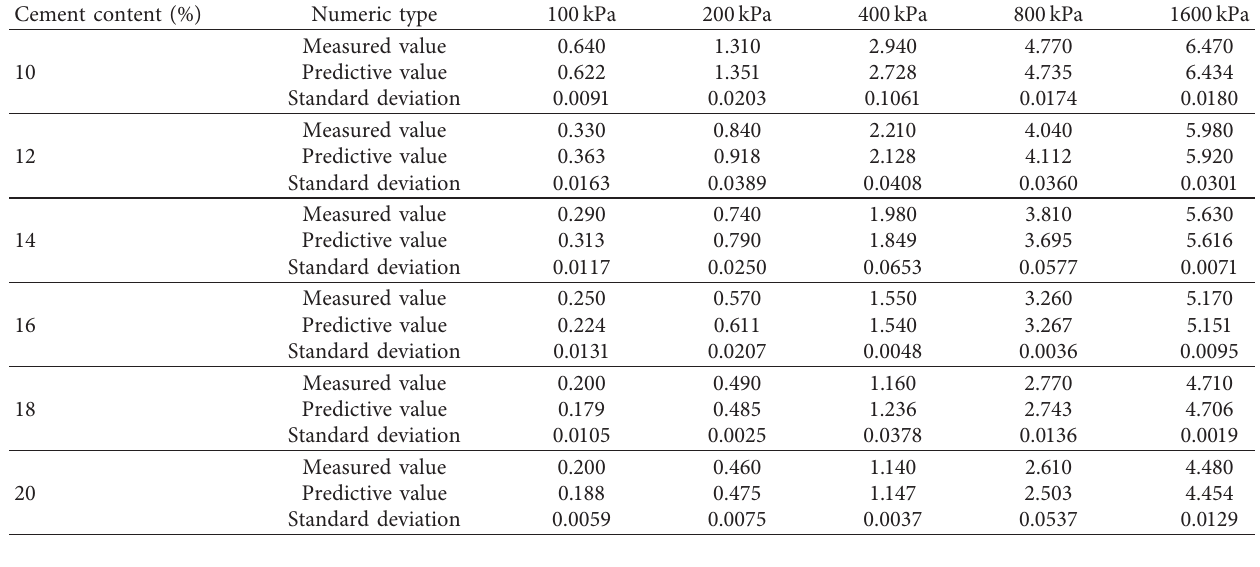
Table 11: Calculated value corresponding to different consolidation pressure under different cement content.